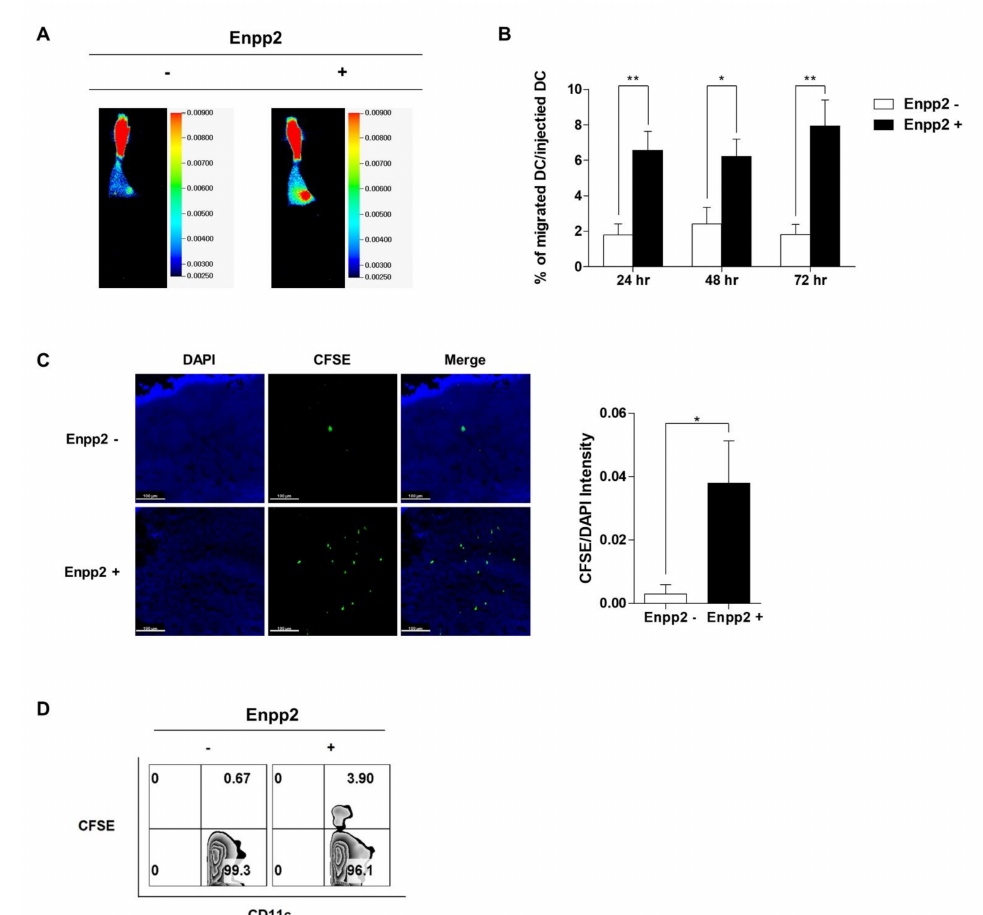
Figure 4. Enpp2 increases the homing ability of mDCs in vivo. DCs were injected subcutaneously into the right hind leg footpad of C57BL/6 mice, and imaged at 24, 48, and 72. ( A ) DCs (5 × 10 4 cells/ 50 µ L) were injected subcutaneously into mouse ( n = 5 mice for each group) footpads to monitor cell migration to the popliteal lymph nodes. Imaging was performed using the near-infrared 800 nm channel, exciting at a wavelength of 778 nm and detecting at 794 nm. Representative optical images ac- quired on day 3 post-injection. ( B ) The bar graphs show that fluorescence intensity of DCs